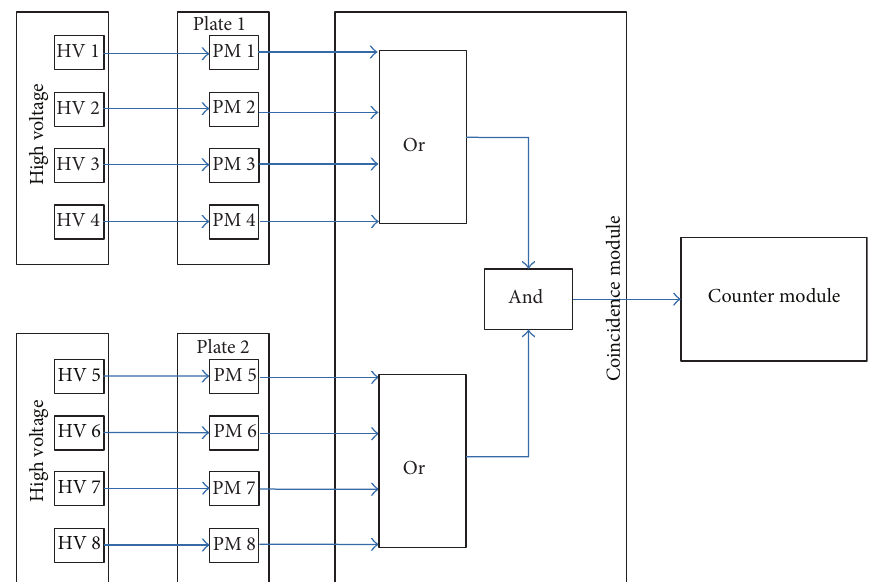
Figure 2: The schematic view of the electronic detection system.